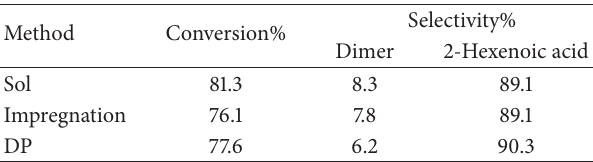
Table3:Effectofpreparationmethodson2-hexenaloxidationusing 1% Au/MnO 2